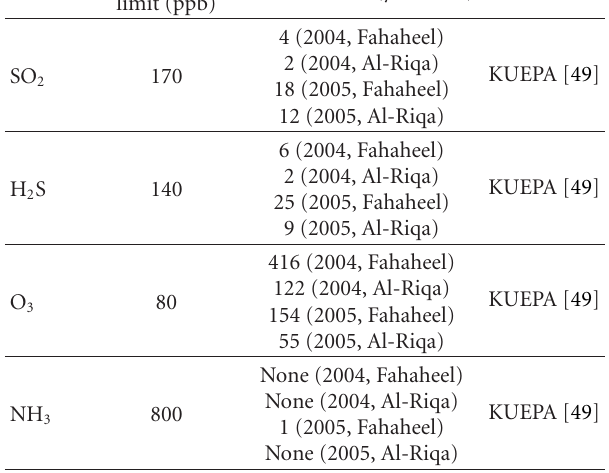
Table 3: Exceedences against KUEPA rules and regulations reported in Fahaheel and Al-Riqa over the period between 2004-2005. Source: Al-Salem and Khan